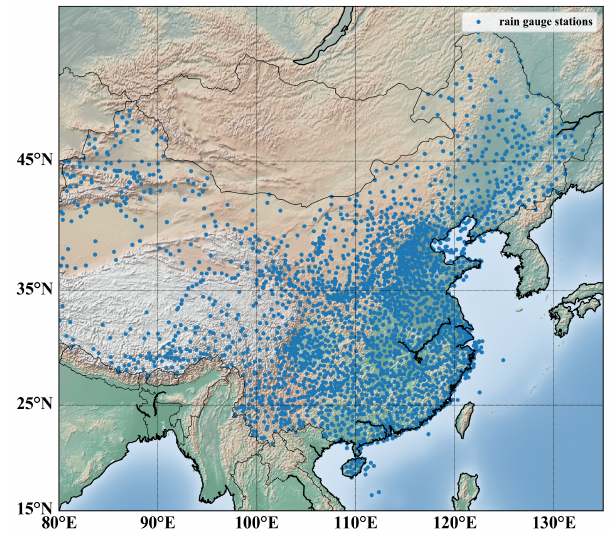
Figure 1. Distribution of the rain gauge stations in the study